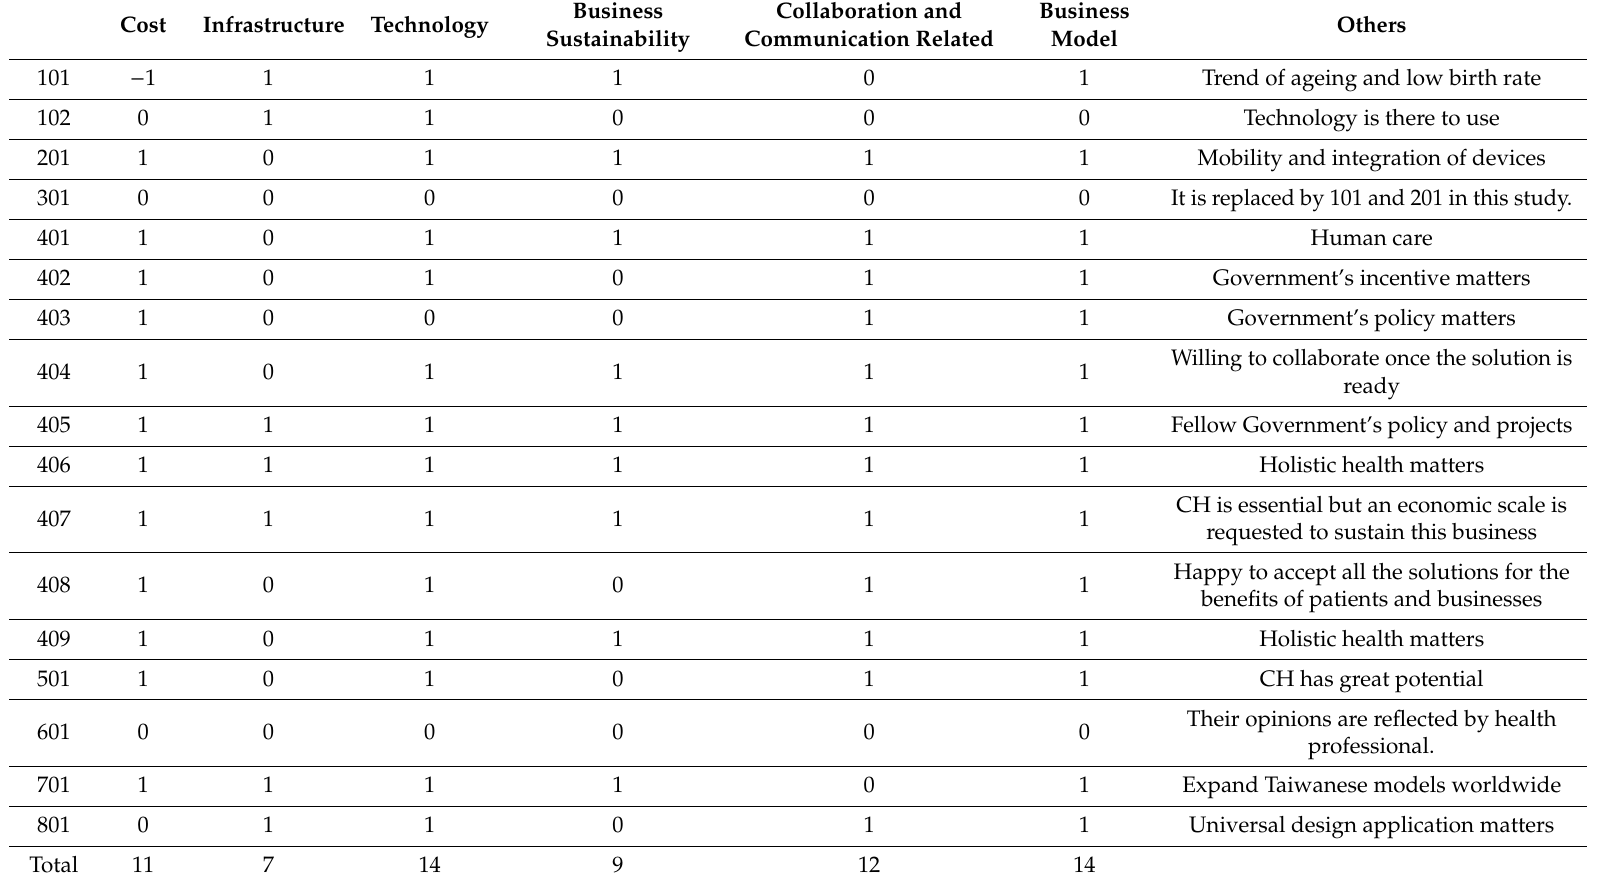
Table 6. Interviewees’ perspectives score in terms of CH